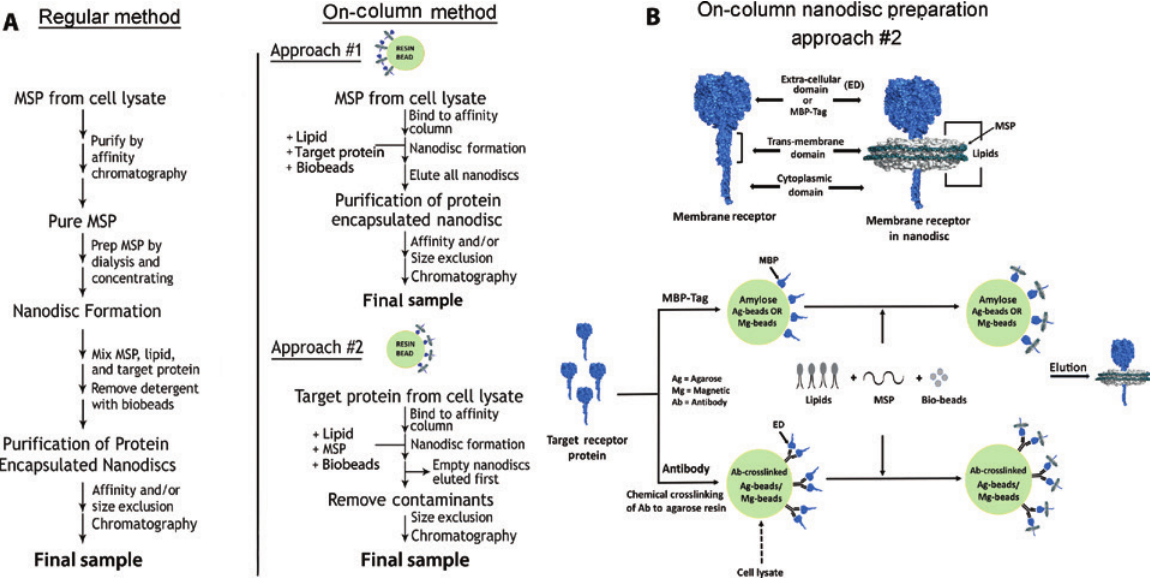
Figure 2: General workflow for nanodisc preparation. (A) Comparison of the regular method to the on-column method. The on-column method is split into two approaches, depending on the immobilization of either MSP or the target protein onto the resin. (B) Schematic rep- resentation of a target protein with its corresponding soluble extra cellular/MBP tag domain, a transmembrane hydrophobic domain, and soluble cytoplasmic domain. Also shown is a nanodisc containing the encapsulated target protein with MSP and lipid molecules (top panel). A more detailed workflow for approach-2 from the on-column method is illustrated. The target protein is bound to the resin either through its affinity for the MBP tag or through the crosslinked antibody specific to the extracellular domain (ED). The addition of MSP, lipids, and bio-beads lead to the encapsulation of the target protein into nanodisc while still bound to the resin. This nanodisc encapsulated protein is finally eluted from the resin (bottom